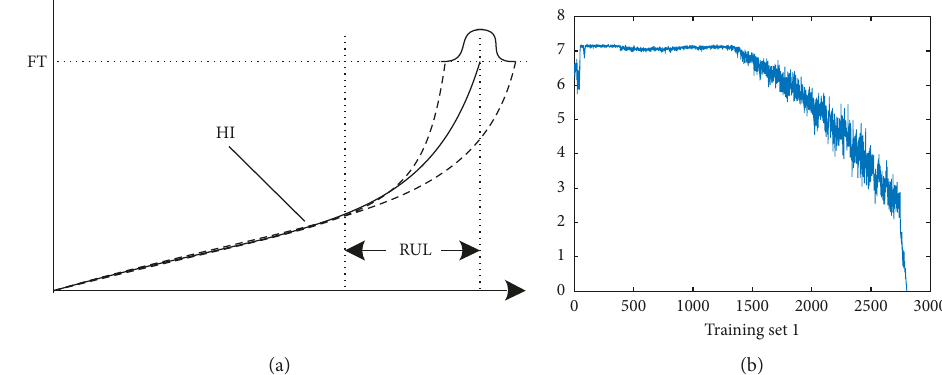
Figure 4: Comparison of HHE and the standard health indicator. (a) The health indicator of the standard model. (b) HHE in the training set